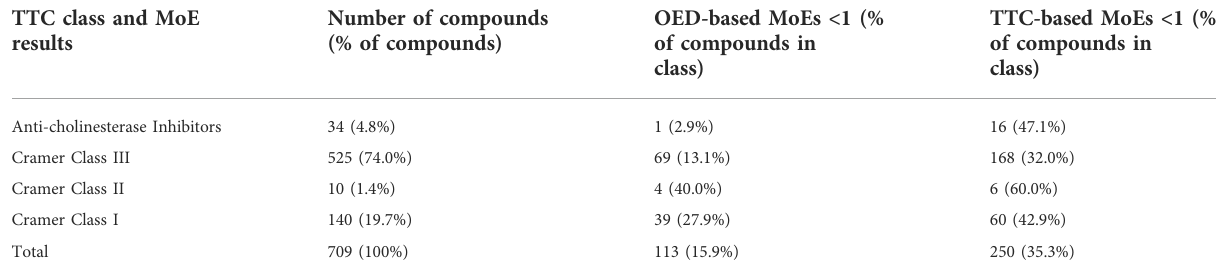
TABLE 1 Summary of 709 ToxCast chemicals with computed oral equivalent doses (OEDs) in the small dataset that are classi fi ed into four noncancer TTC categories based on Cramer decision tree results, along with the number of chemicals with estimated OED- and noncancer TTC-based margins of exposure (MoEs) of less than